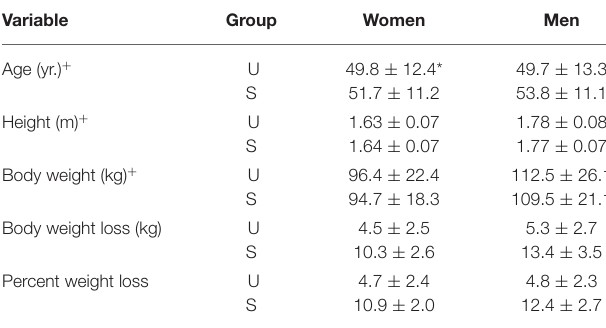
* Values are means ± SD. + Values obtained at the screening visit. For each variable, the number of subjects was 138 and 1,214 for U and S women, respectively. The corresponding number for men was 53 and